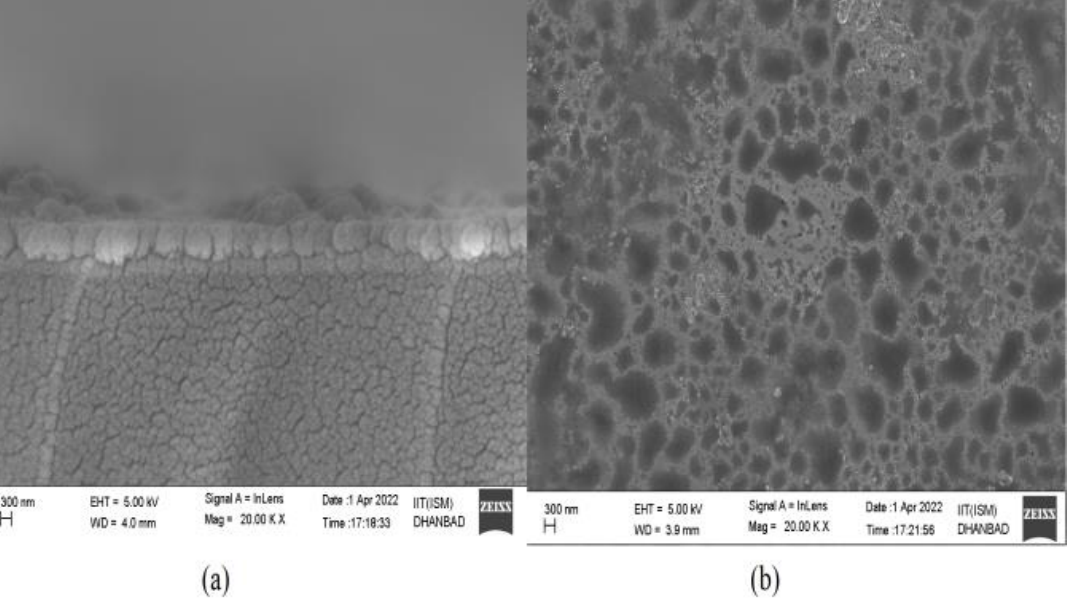
Figure 9. ( a ) Cross-sectional view and ( b ) top view of the deposited material on sample through FESEM image.